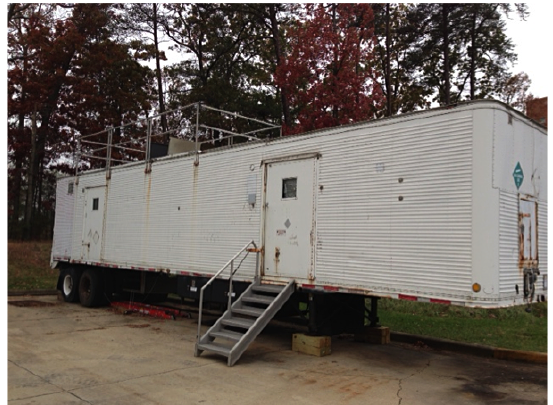
Figure 4. The 13 m trailer that houses the GSFC TROPOZ DIAL system. The hatch doors are open to transmit the DIAL wavelengths into the